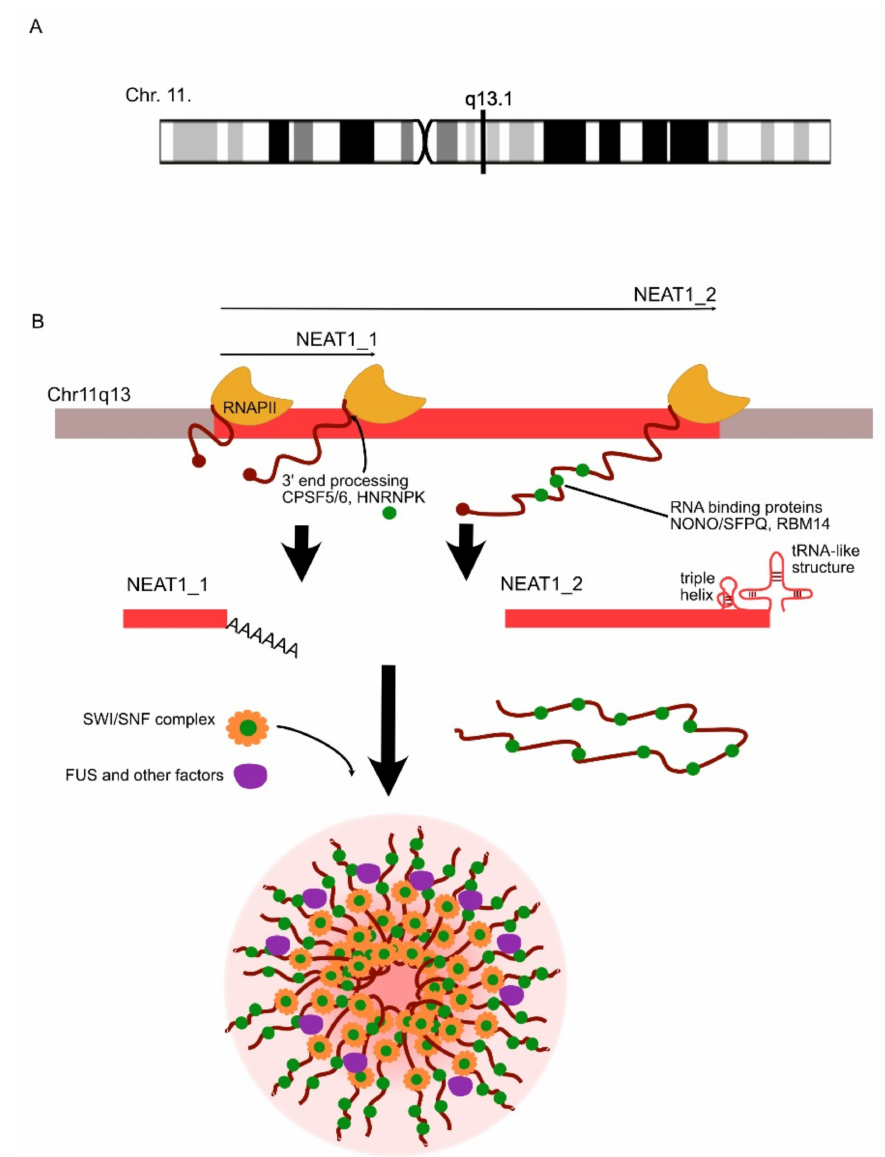
Figure 5. NEAT1 in paraspeckle formation. ( A ) The NEAT1 locus is localized on chromosome 11 (www.genecards.org, accessed on 28 April 2021). ( B ) NEAT1 can be transcribed by the RNAPII into NEAT_1 or NEAT_2 transcripts, which vary in the structure of their 3 (cid:48) end. The dot at the 5 (cid:48) end of each variant represents the structure of a cap. The triple helix and tRNA-like structure at the 3 (cid:48) -end of NEAT1_2 prevent the polyadenylation at the 3 (cid:48) -end of this isoform. HNRNPK (heterogeneous nuclear ribonucleoprotein K) is a crucial factor for NEAT1_2 processing, as it prevents NEAT1_1 polyadenylation, which is dependent on SPSF5/6. NEAT1_2 additionally binds stabilizing PLD (phospholipase D)-containing, RNA-binding proteins such as NONO (non-POU domain-containing, octamer-binding protein), SFPQ (splicing factor, proline- and glutamine = rich) or RBM14 (RNA binding protein 14). The NEAT1 lncRNA is localized into the cellular inclusions along with SWI/SNF (SWItch/sucrose non-fermentable) complexes (made out of grouped stabilizing, PLD-containing proteins) and FUS and other PLD-containing